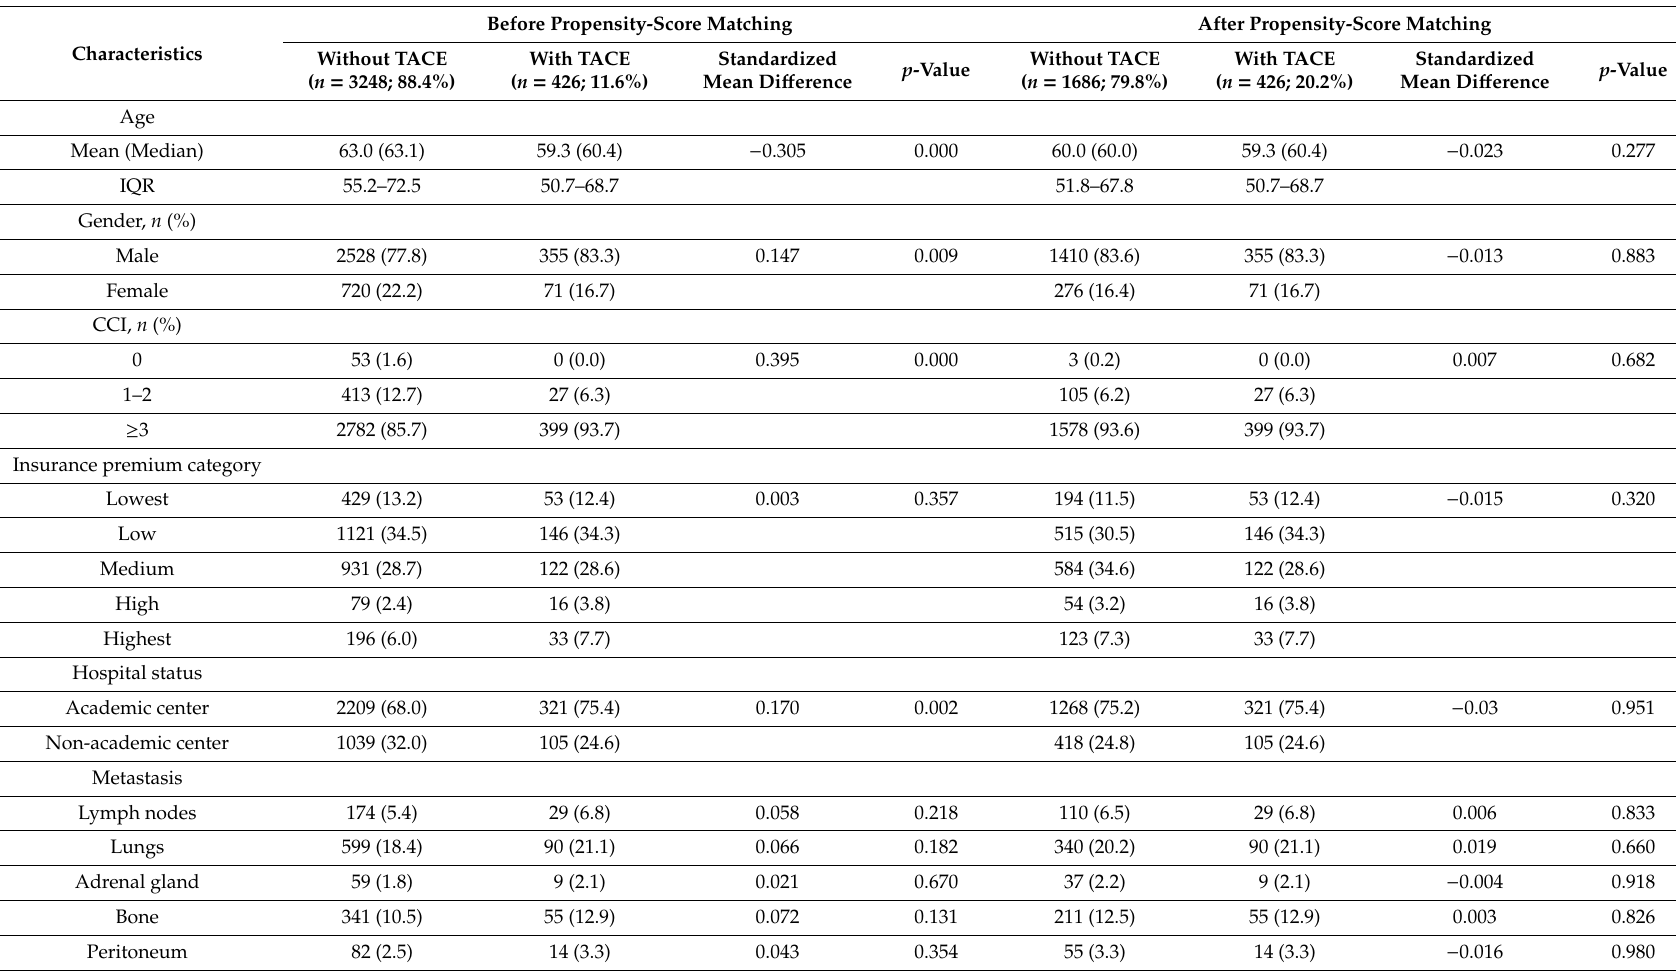
Table 1. Baseline characteristics of patients with advanced hepatocellular carcinoma (Child-Pugh A) receiving sorafenib with or without add-on transarterial chemoembolization (TACE), before and after propensity-score matching. (All-Cancer Dataset 2008–2010).